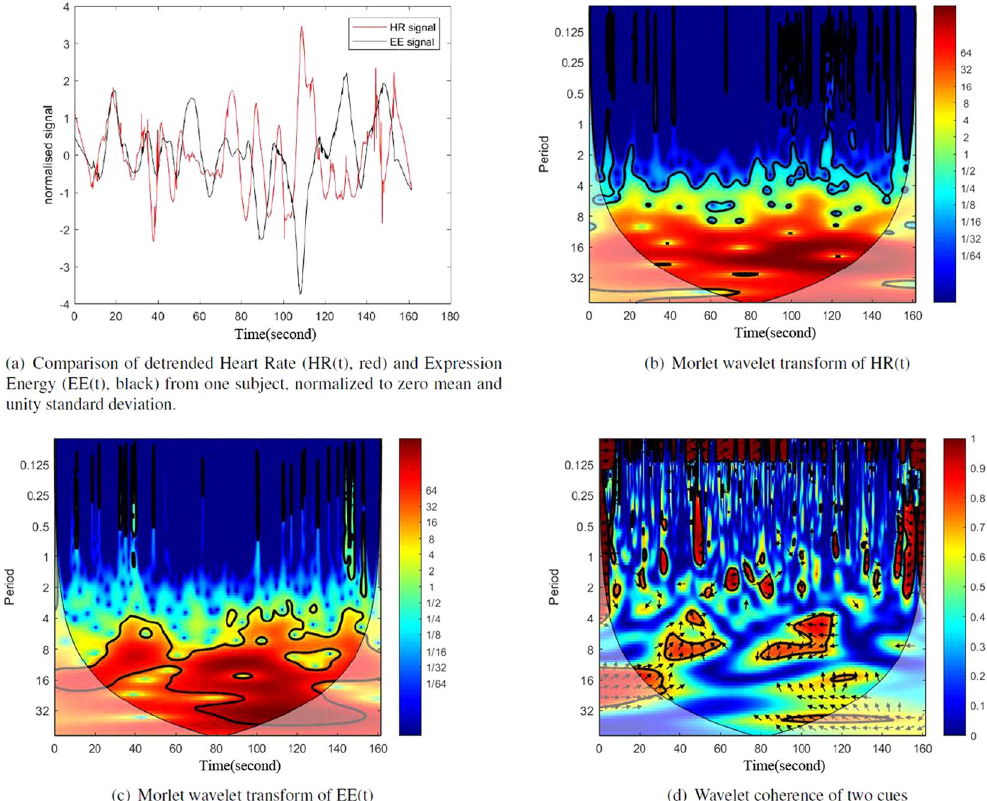
Figure 6. Wavelet coherence analysis of the example pair of HR(t) and EE(t) signals shown in ( a